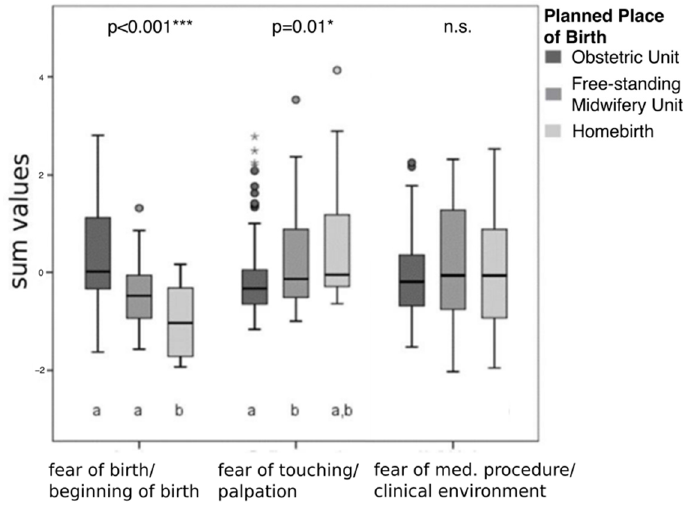
Figure 1. Association between planned place of birth and birth anxiety. Note: Boxplots show the median, 25%/75% quartile, whiskers with minimum/maximum as well as outliers as stars, p = p -value (* p < 0.05, *** p < 0.001, n.s. = non-significant), a/b = result of post hoc analysis to indicate statistically significant differences between the birthplace groups.